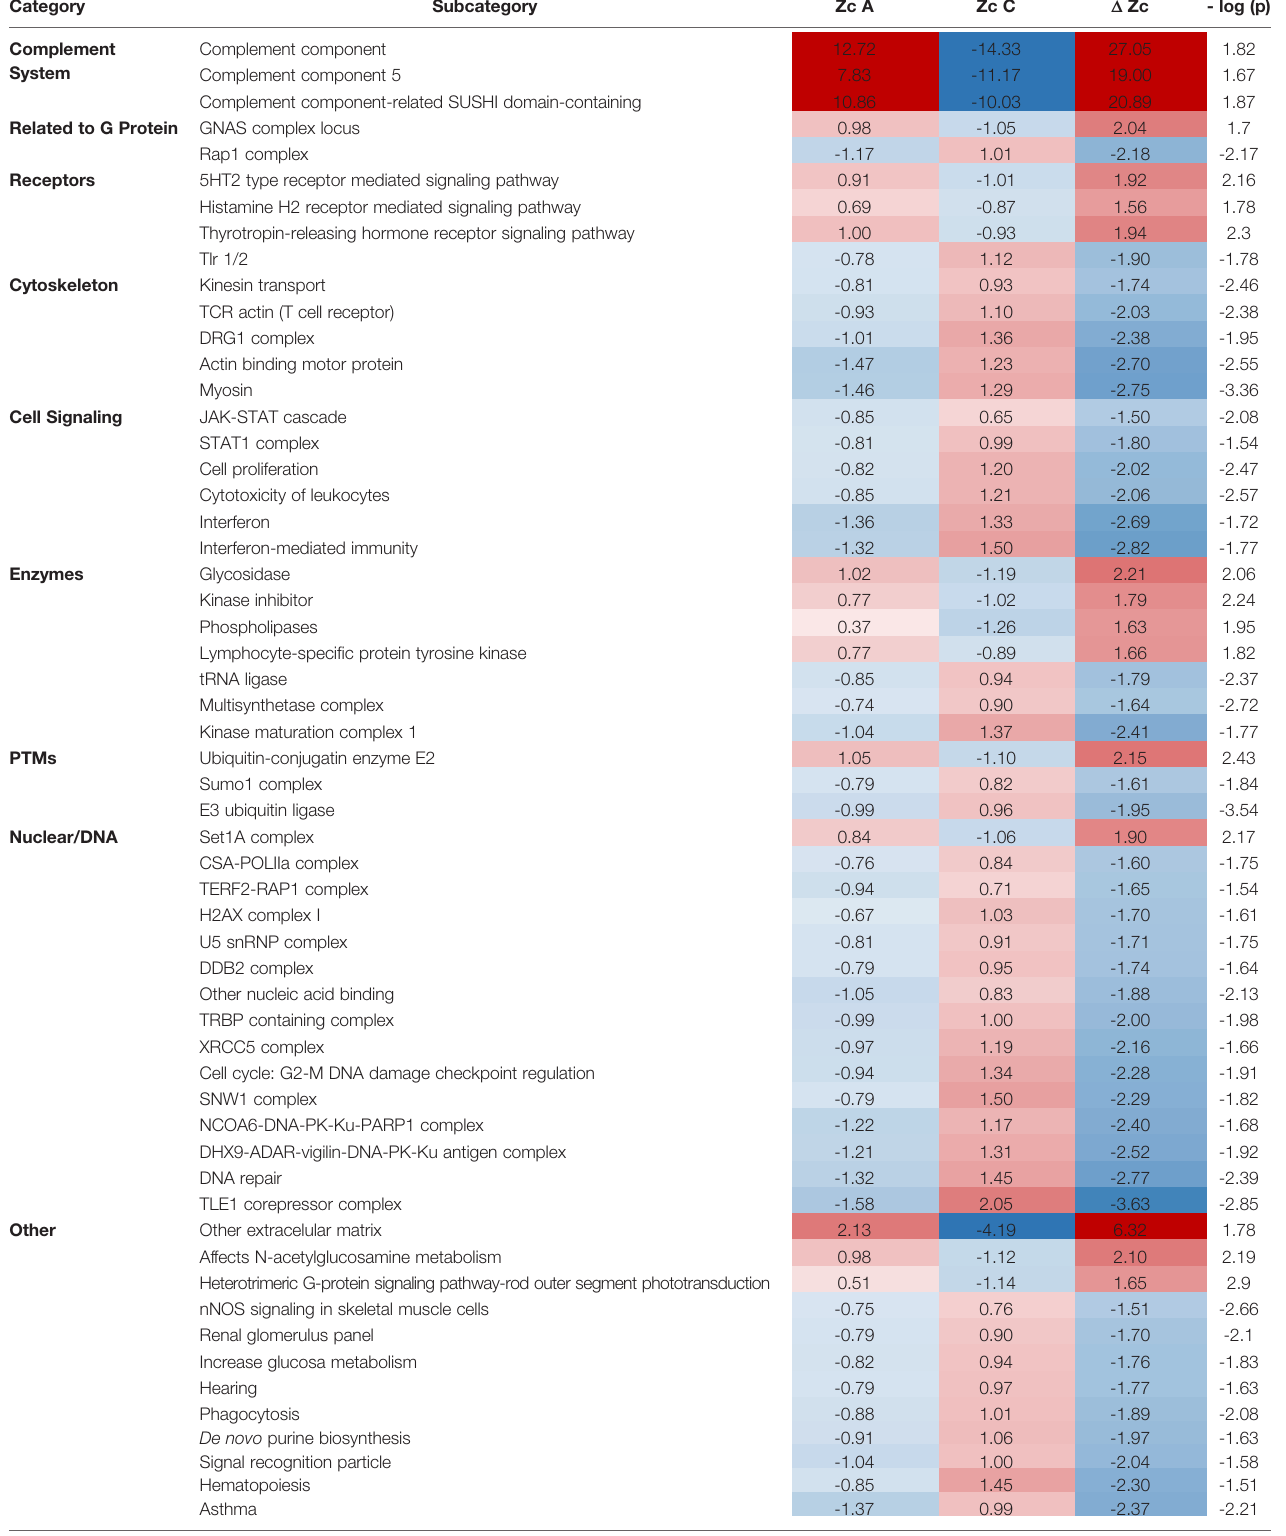
TABLE 3 | Main altered functional categories in EC-anaphylaxis compared to EC-control system. Category